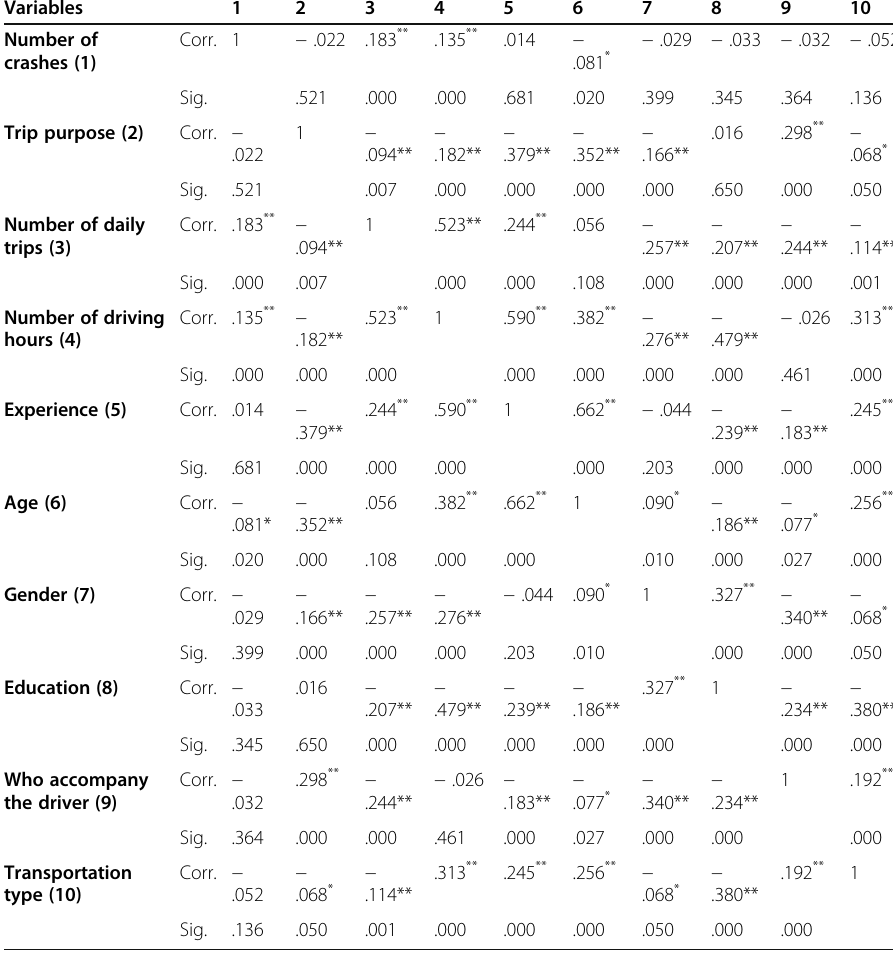
Table 2 Driver demographics variables correlation analysis